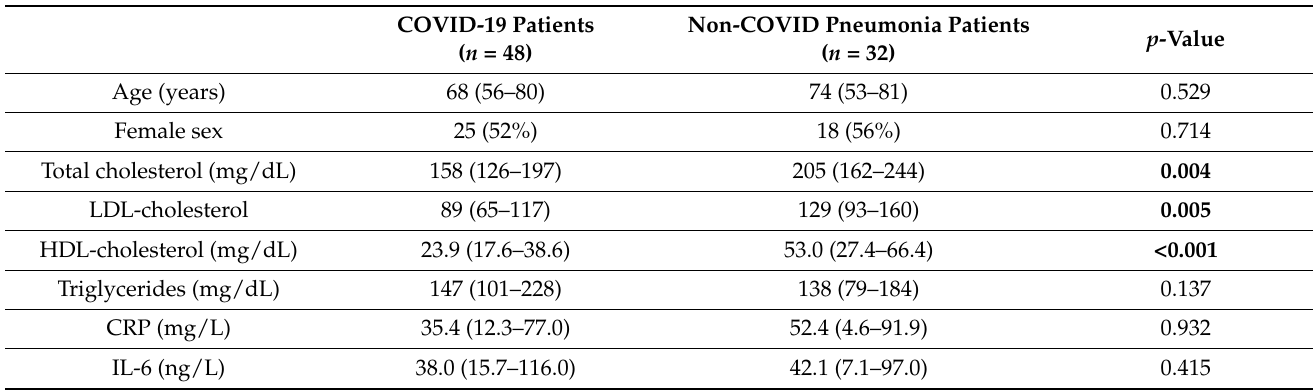
Table 1. Baseline characteristics of the study